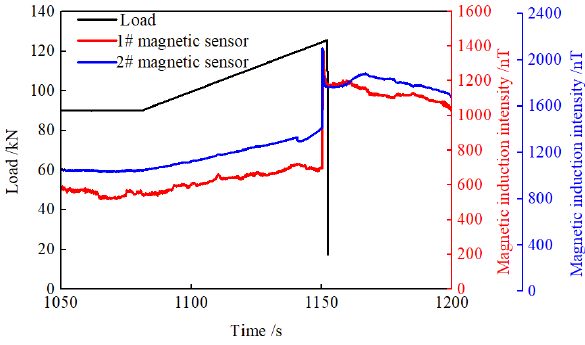
Figure 8. The load ‐ magnetic curve of the last stage during grading loading. Figure 8. The load-magnetic curve of the last stage during grading